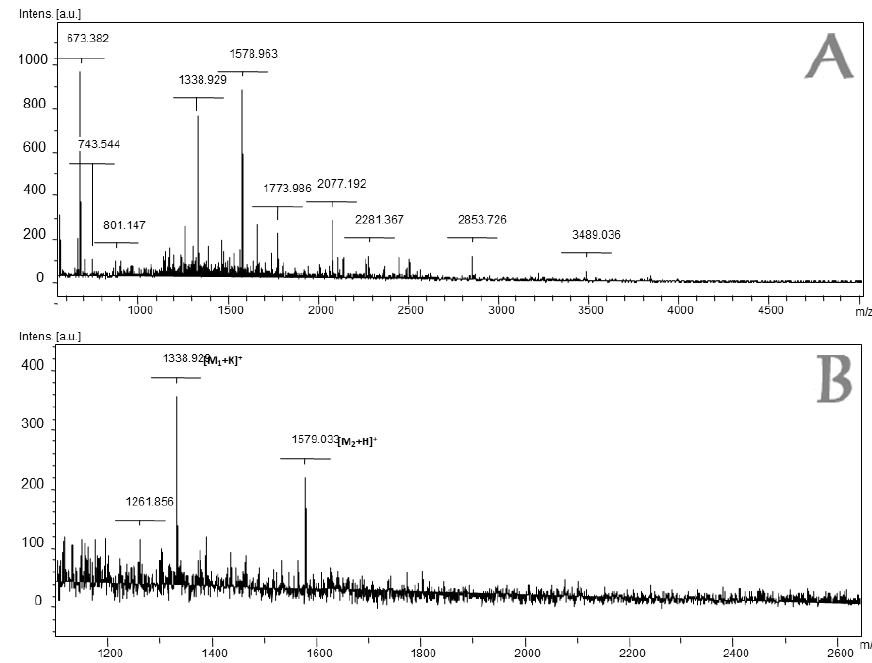
Figure 2. MALDI-TOF Mass Spectrum of the fraction 4 of L. latrans . ( A ) MS-MALDI-TOF in the range 1000 – 4500 Da; ( B ) Broad spectrum in the region 1100 – 2600 Da.